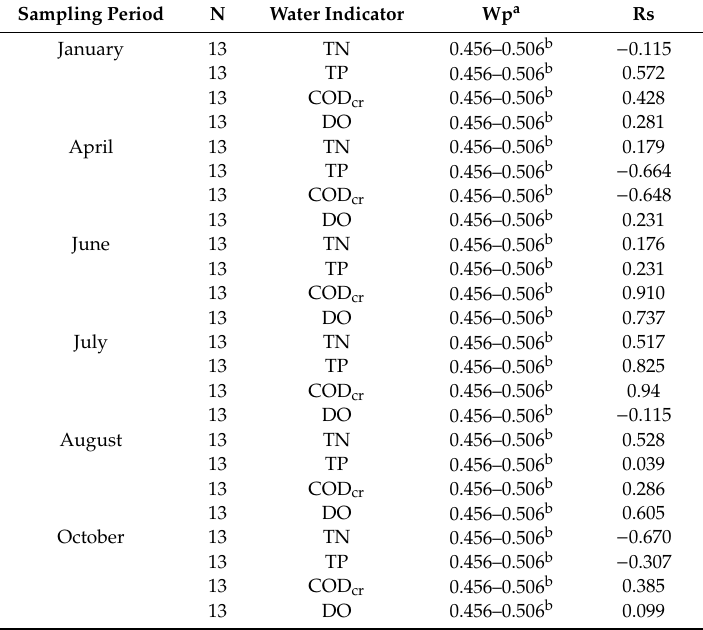
Table 4. Spatial variation in the WPI values calculated by the Daniel trend method in six sampling months.